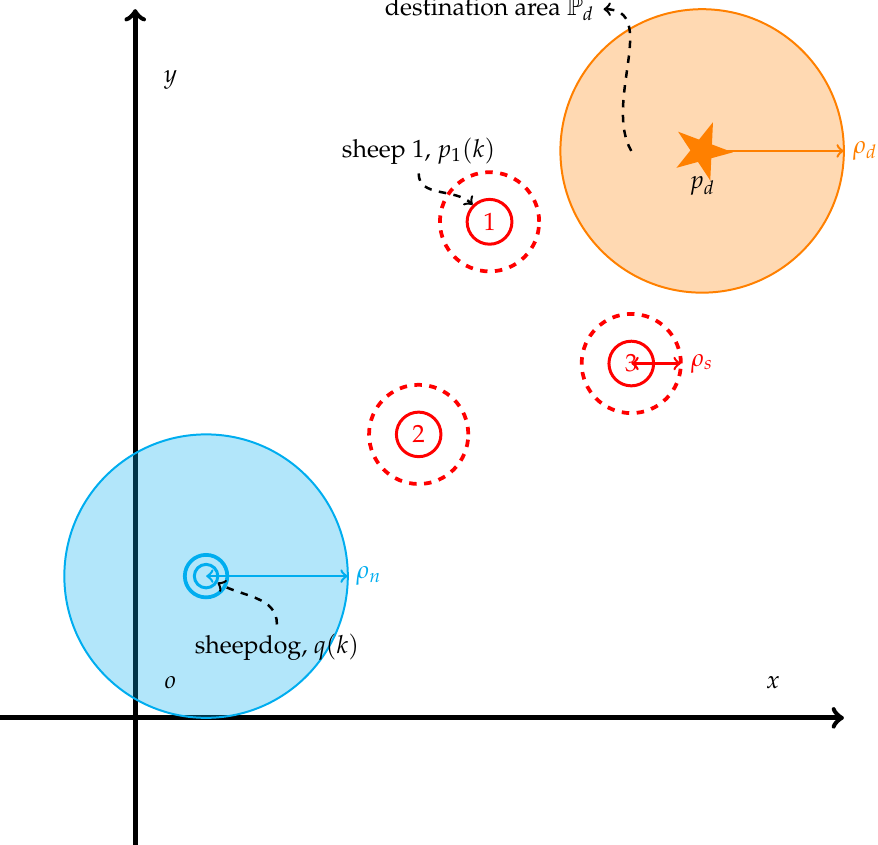
Figure 2. An example of the herding problem with 3 sheep, denoted by red circles with labels, and 1 sheepdog, denoted by a blue circle. The destination area (in orange) is centered at p d